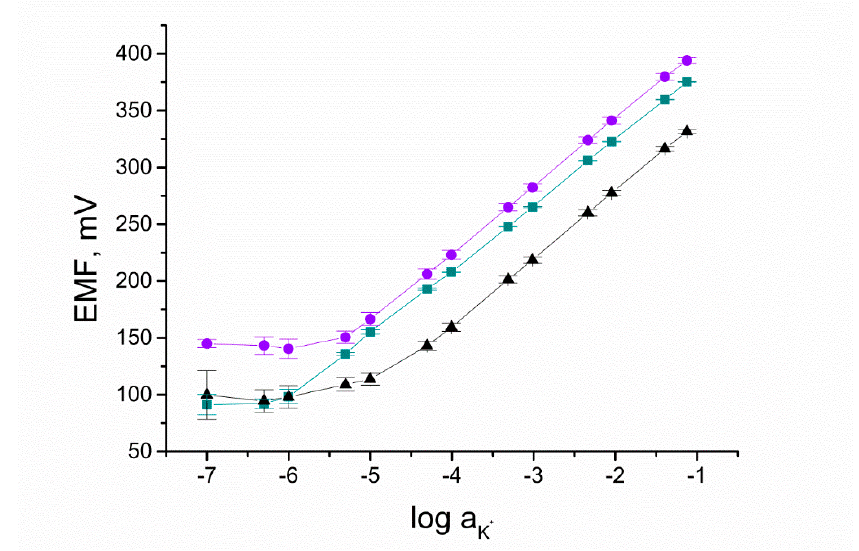
Figure 11. Calibration curves recorded for GCD/RuO 2 •xH 2 O/K + -ISM ( ), GCD/RuO 2 /K + -ISM ( ), and GCD/K + -ISM ( ) electrode.